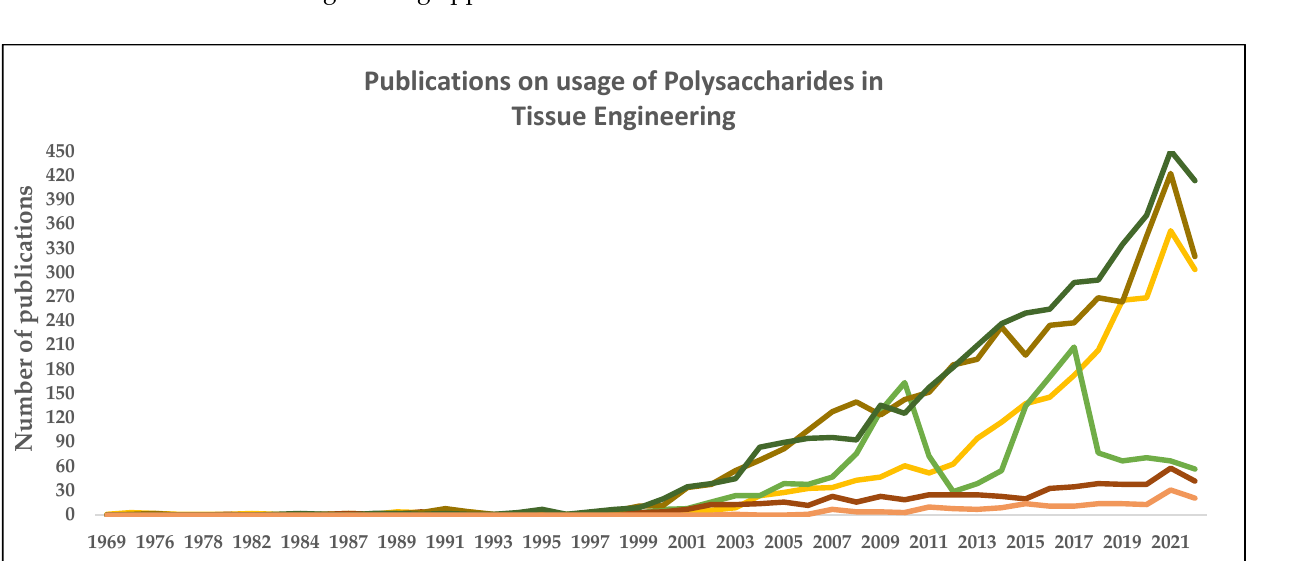
Figure 8. Publications on the usage of polysaccharides in tissue engineering. (The number of papers published on individual polysaccharides such as cellulose, chitin, alginate, starch, hyaluronic acid, and pullulan is drawn based on the year and the respective total number of papers published, using search engine: www.scopus.com, accessed on 15 January